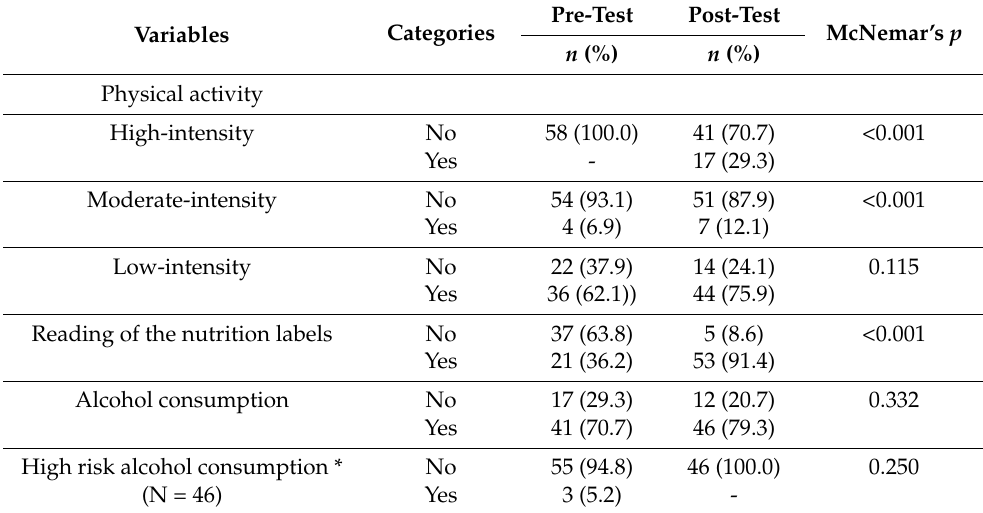
Table 4. Effects of the PAR program on health behaviors ( N =